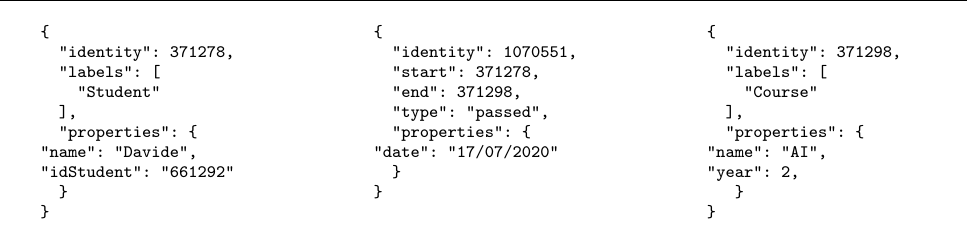
Table 6. JSON fragment of the graph.